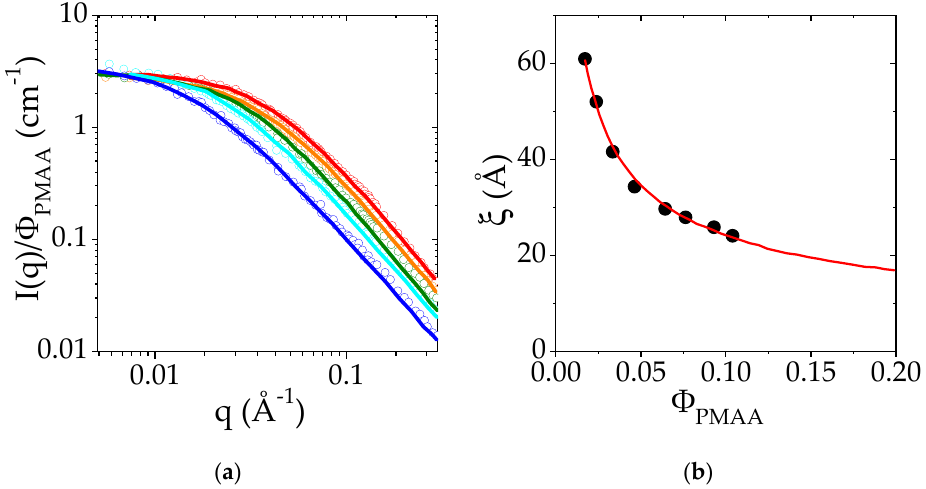
Figure 3. ( a ) Small-Angle Neutron Scattering intensity I as a function of the scattering wavevector q measured at 25 °C for different PMAA volume fractions in the semi-dilute regime (from 0.023 to 0.104): Φ PMAA = 0.023 in dark blue, Φ PMAA = 0.038 in light blue, Φ PMAA = 0.058 in green, Φ PMAA = 0.0775 in yellow, Φ PMAA = 0.104 in red. The I(q) curves were divided for the sake of comparison by Φ PMAA . Solid lines are the fits of the experimental data to an Orstein–Zernike function. ( b ) Variation of the correlation length ξ with the polymer volume fraction, Φ PMAA . The red line corresponds to the fit of ξ ( Φ PMAA ) to a power law.